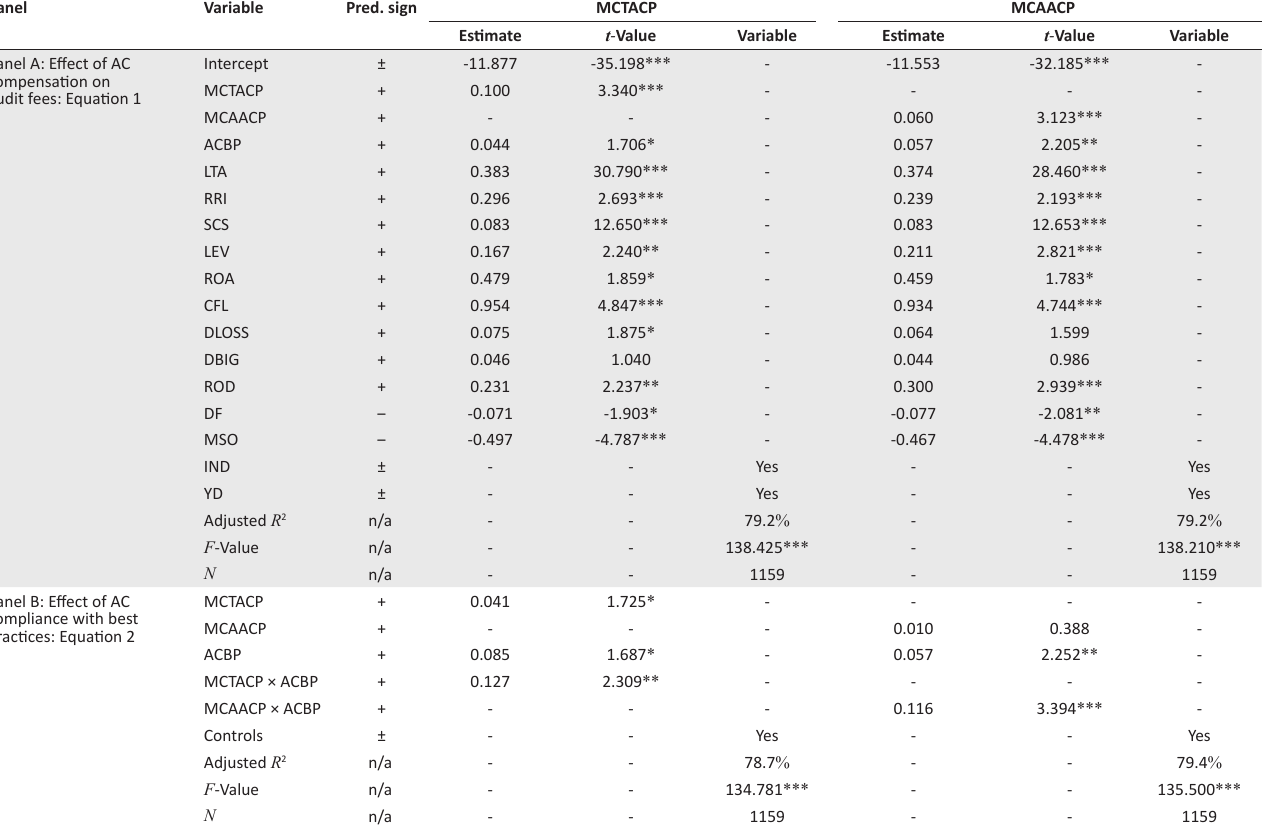
TABLE 4: Audit committee compensation, compliance with best practices and audit fees.